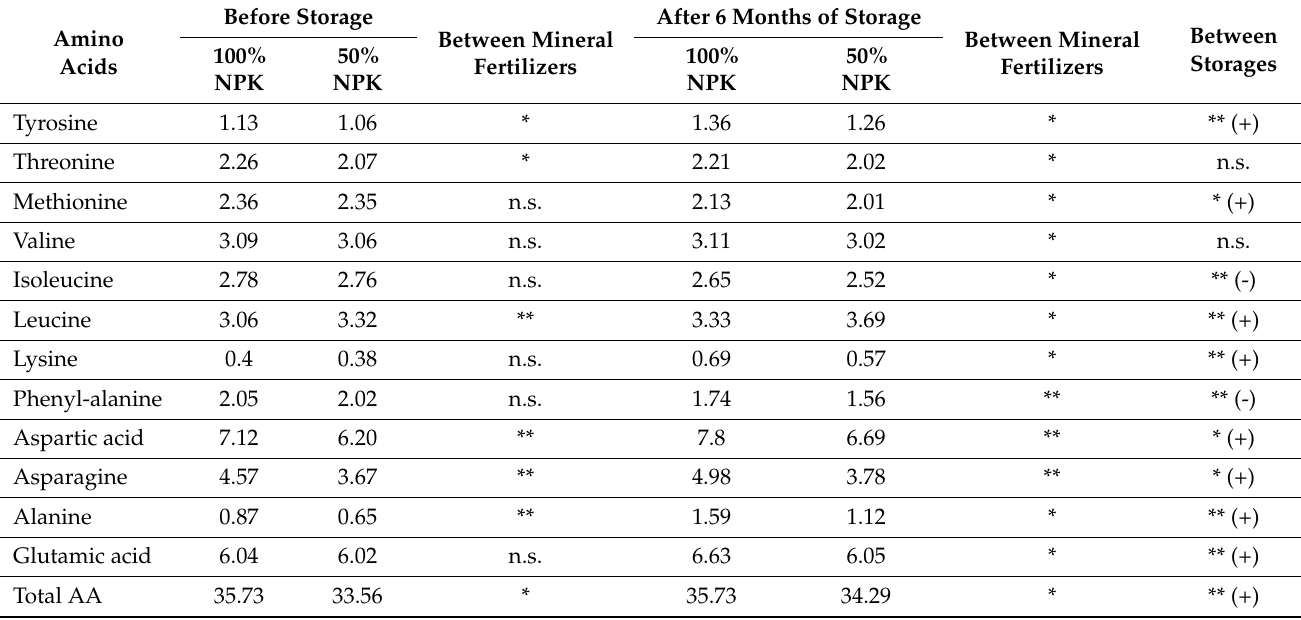
Table 12. Effect of mineral fertilization and storage on the amino acid composition of potato tubers (g 100 g − 1 protein) (mean from 3